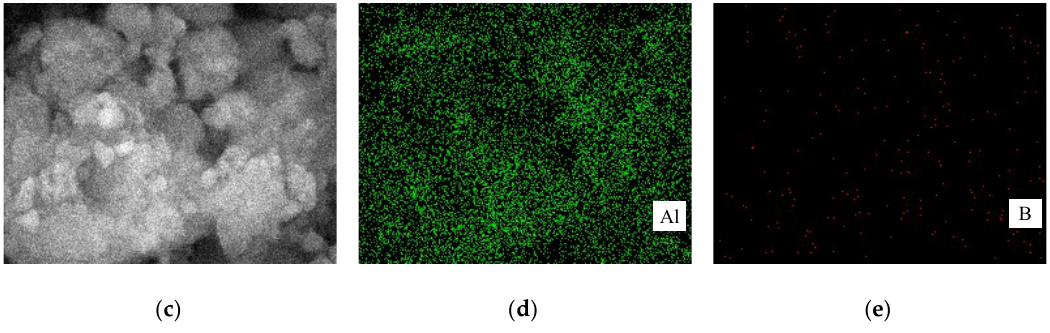
Figure 1. SEM images of LiBH 4 /LiAlH 4 mixture before ( a ) and after ( b ) ball-milling and micro-selection area ( c ) and elemental mapping of Aluminum ( d ) and Boron ( e ) in the as-prepared LiBH 4 /LiAlH 4 composite.